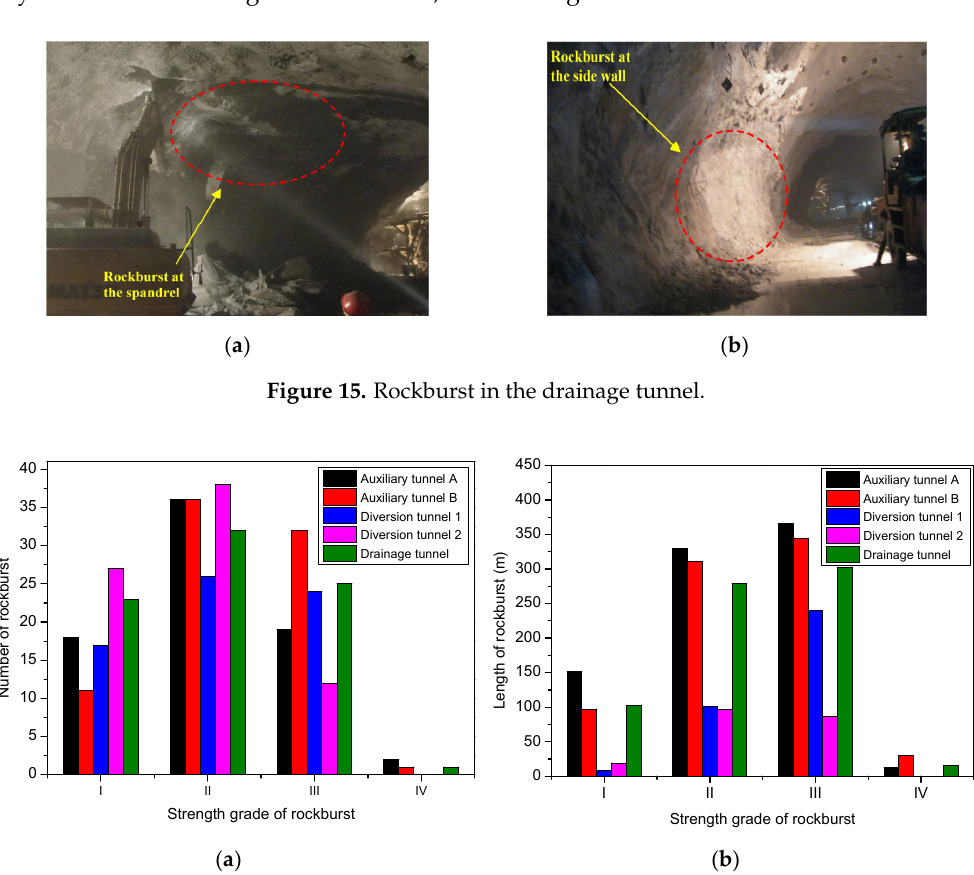
Figure 16. Rockburst statistics in auxiliary tunnel, diversion tunnel and drainage tunnel: ( a ) The number of rockbursts: ( b ) The length of rockburst.